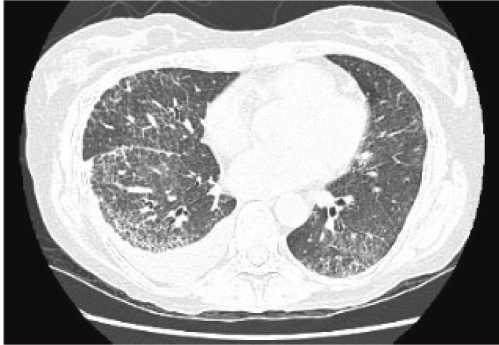
Figure 1: HRCT showing UIP (followup scan, May 2008).